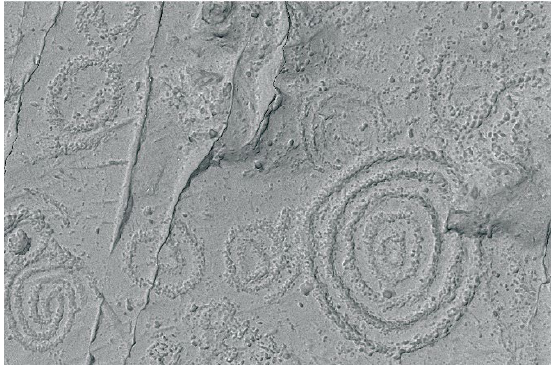
Figure 12b. A similarly generated radiance scaling visualisation of the same section of the HD model, showing clear improvement in the resolution and resultant sharpness of feature definition.